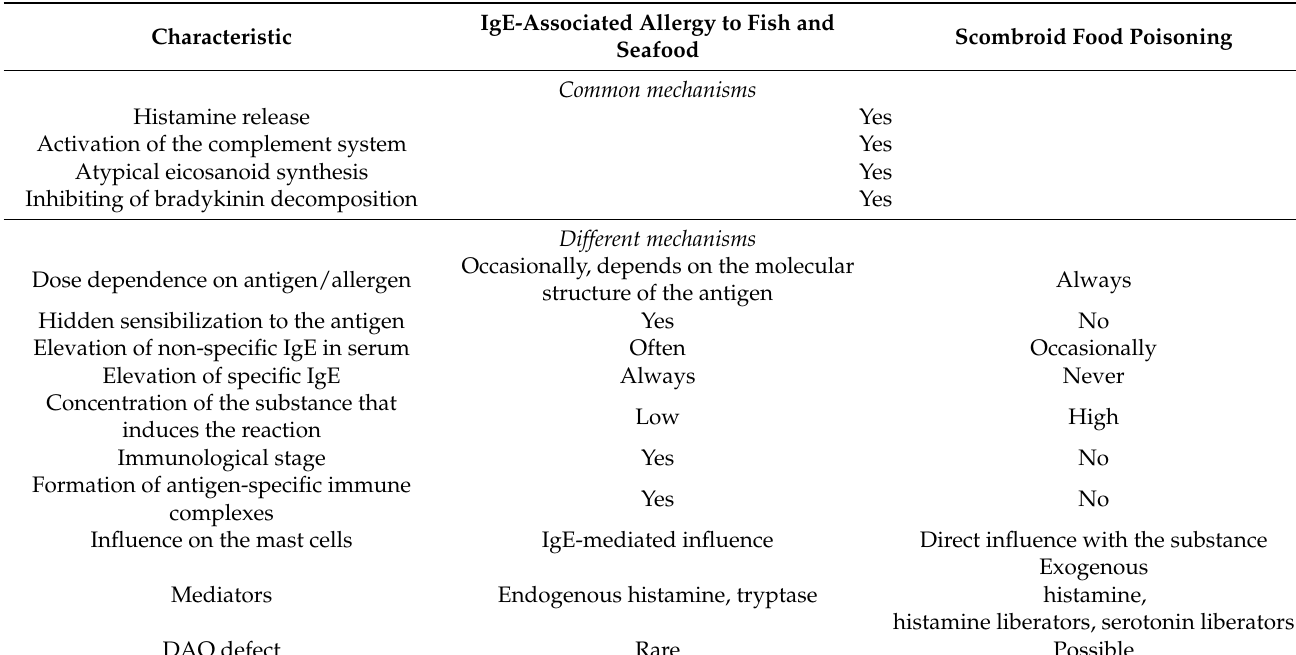
Table 2. The distinctions in mechanisms between true IgE-associated allergies to fish and seafood and